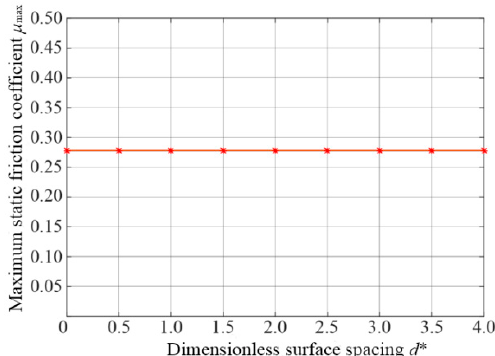
Figure 12. Change of maximum static friction coefficient between the bottom of grouting clamp wedge and steel pipe contact surface.